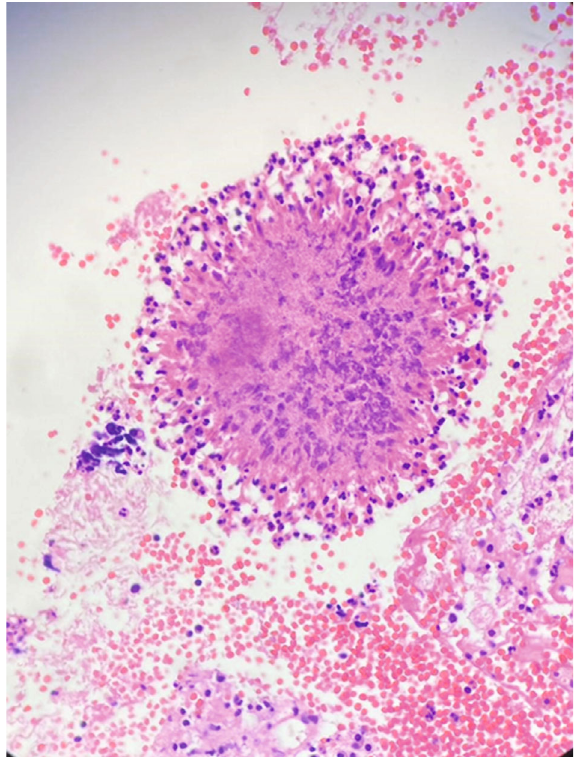
Figure 4: The suppurative exudate focally surrounding colonies of fi lamentous bacteria as round basophilic masses with radial con fi guration resembling “ sulfur granules ” (H&E staining, magni fi cation level 10 × 40 ).